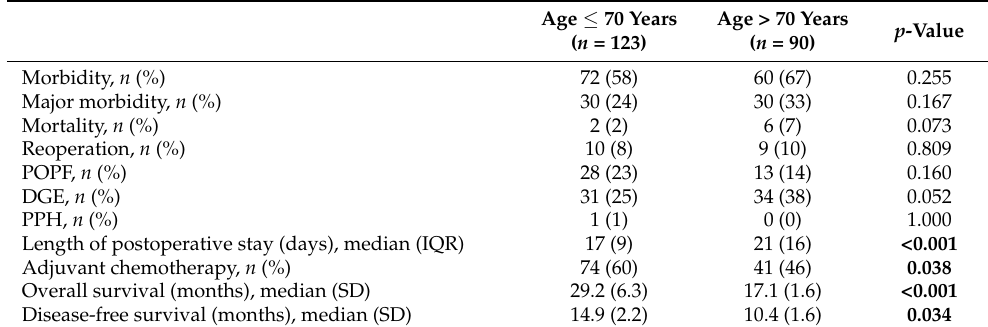
Table 3. Outcome parameter of patients undergoing pancreatic resection for pancreatic ductal adenocarcinoma stratified to age ( ≤ 70 years vs. >70